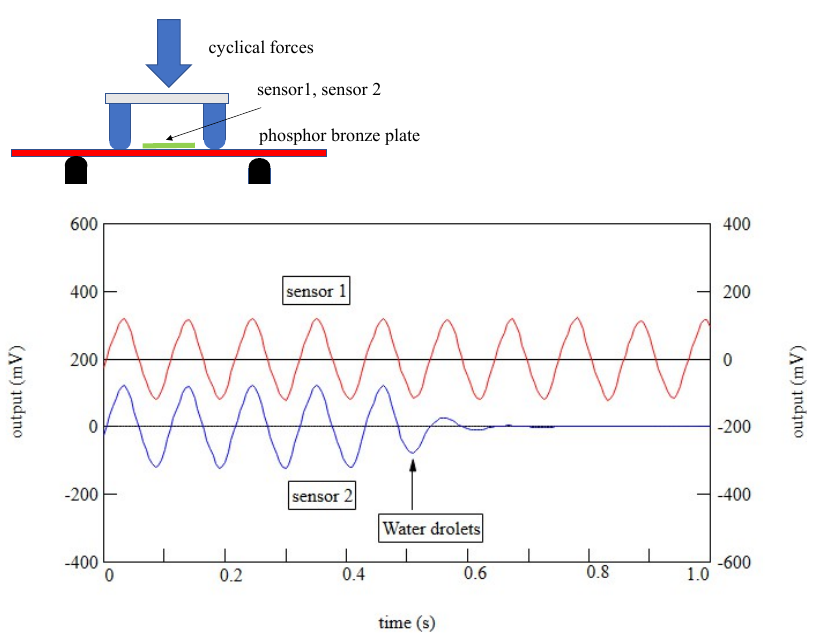
Figure 3. Piezoelectric PLLA braided cord.